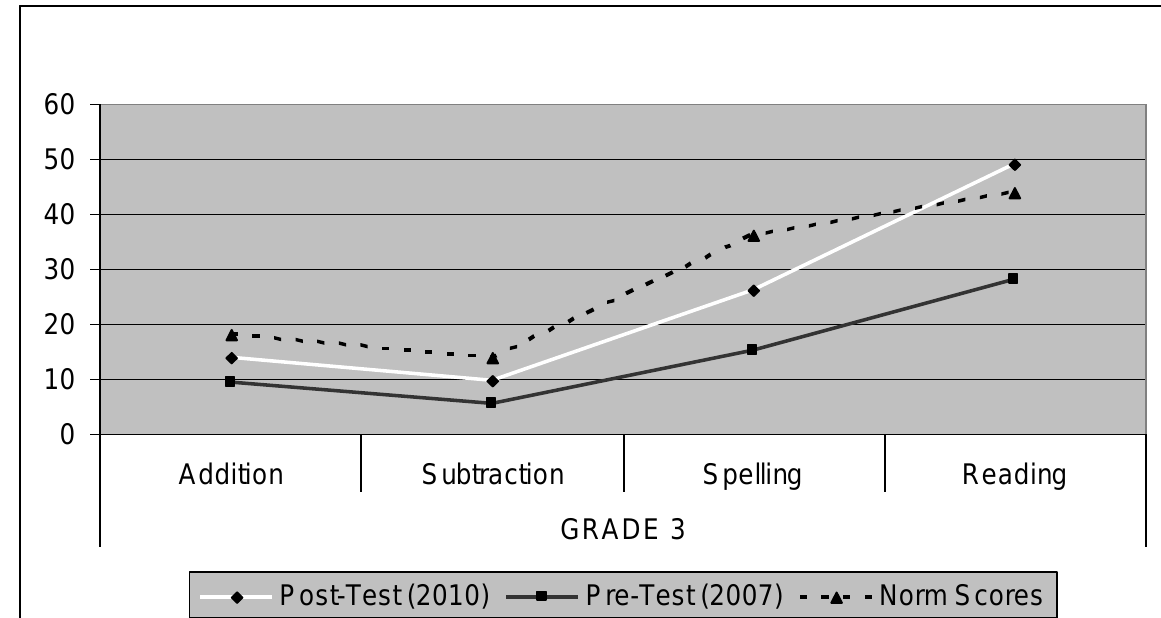
Figure 7 Pre and Post Test Mean Scholastic Scores for Grade 3